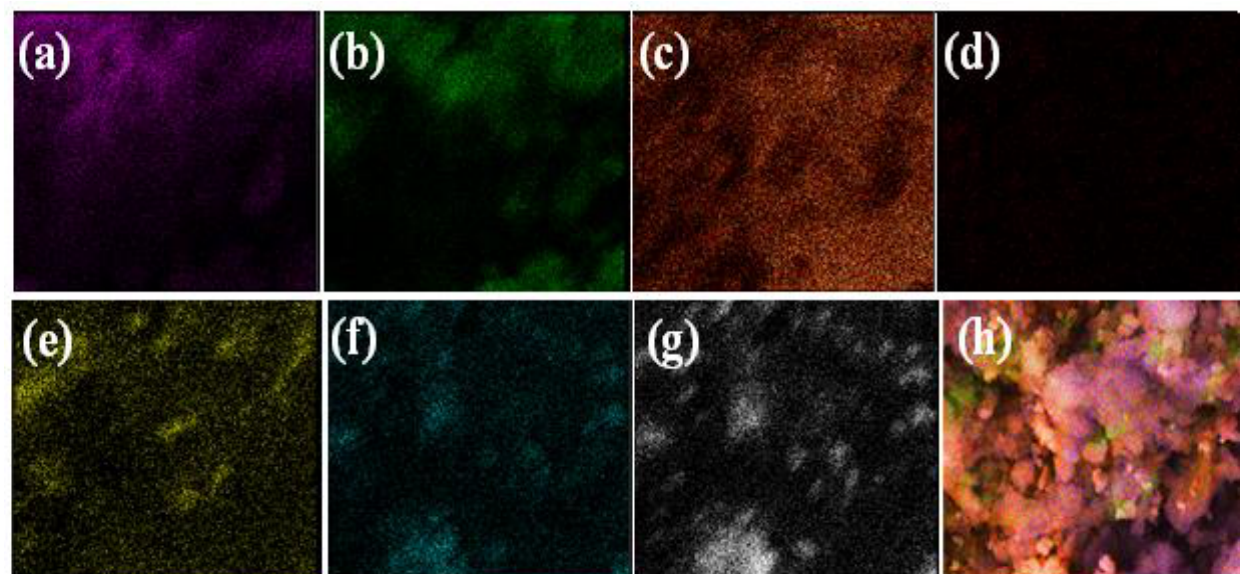
Figure 4. Elemental mapping Ni 3 S 4 /Ag 2 S/TiO 2 /CA. Carbon ( a ), oxygen ( b ), Titanium ( c ), Nickel ( d ), Ca ( e ), Sulfur ( f ), Ag ( g ) and mixed elemental mapping of all elements ( h ). The XRD pattern of CA, Ni 3 S 4 /CA, Ag 2 S/CA and Ni 3 S 4 /Ag 2 S/TiO 2 /CA are presented